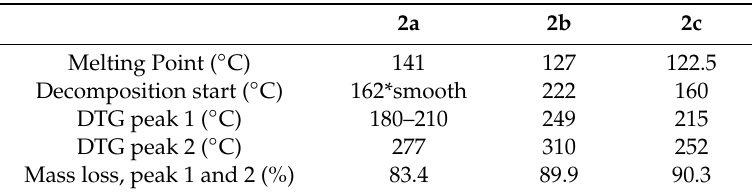
Figure 7. Thermogravimetric (TG), differential scanning calorimetry (DSC) and differential Thermogravimetric (TG), di ff erential scanning calorimetry (DSC) and di ff erential thermogravimetric (DTG) curves of crystals: 2a (a) , 2b (b) and 2c (c) . thermogravimetric (DTG) curves of crystals: 2a ( a ), 2b ( b ) and 2c ( c ). Table 3. Thermal decomposition features of crystals